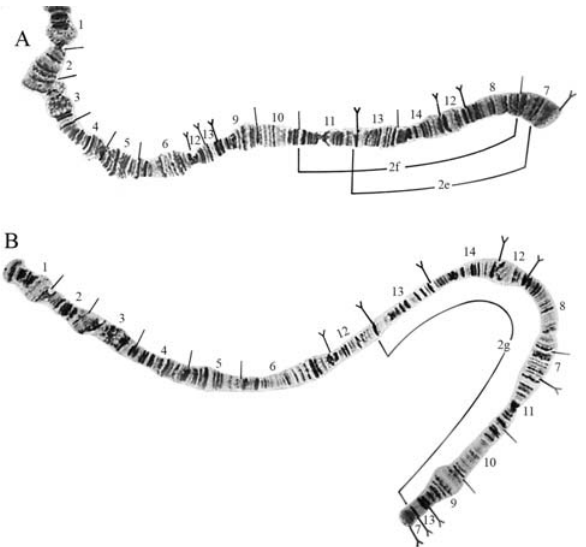
Figure 9 - Photomicrographic maps of Drosophila arassari chromosome 2; the breakpoints of the inversions are indicated. A: D. arassari standard sequence with the breakpoints of inversions 2e and 2f indicated; B: chro- mosome 2 homozygous for inversion